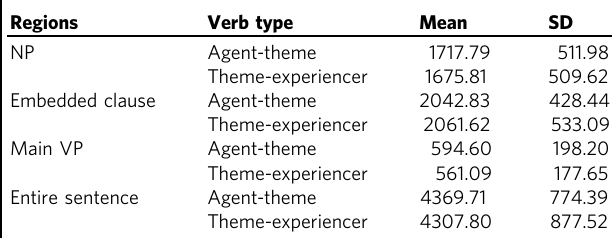
Fig. 3 Reading times for SRC and ORC with inanimate head nouns in different regions. This fi gure shows the results of reading times for SRC and ORC with inanimate head nouns in different regions in Experiment 2.